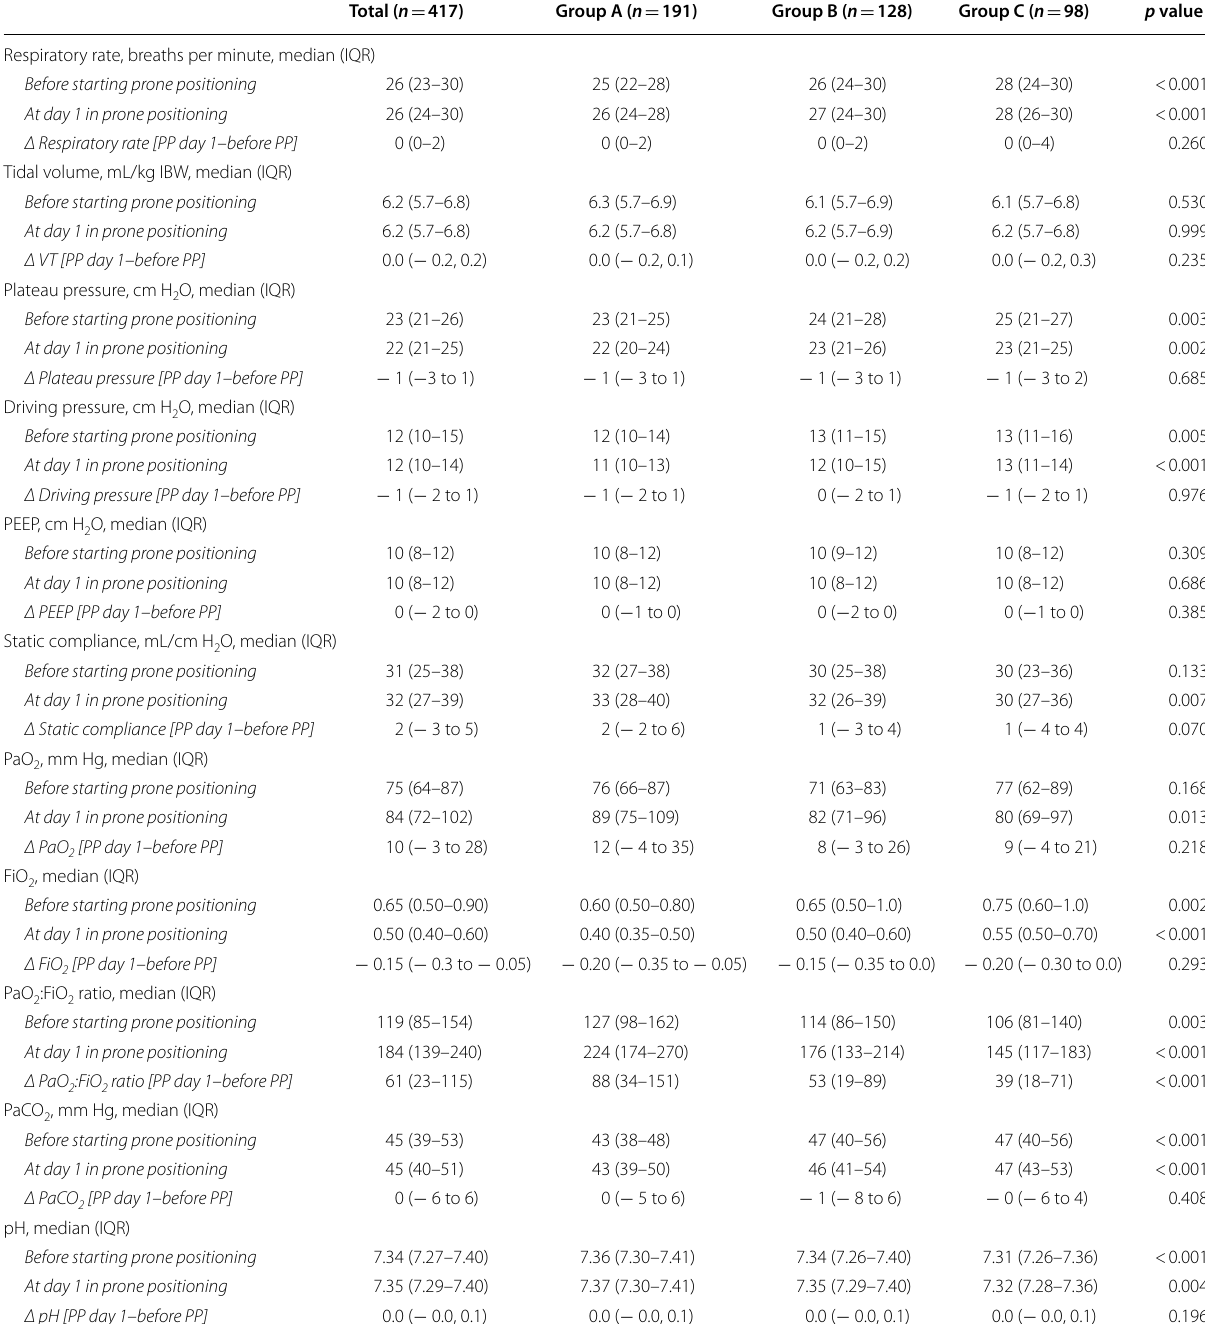
Table 2 Respiratory parameters before and after starting the first prone session